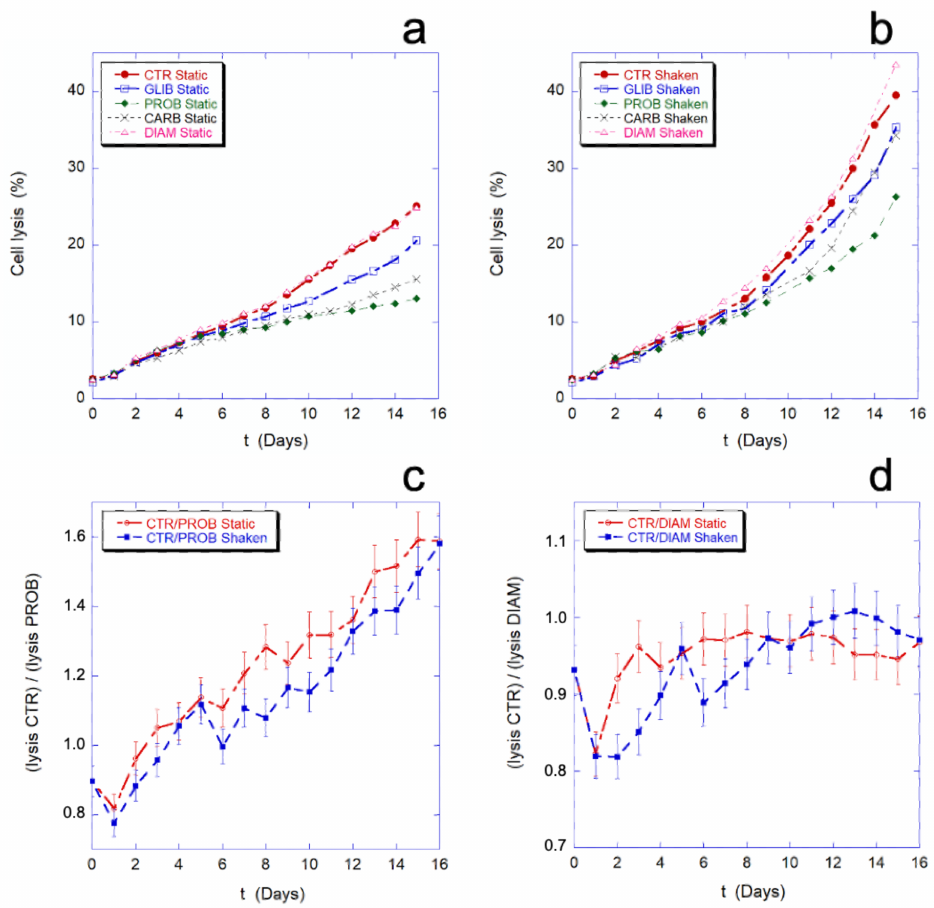
Figure 9. Panels ( a , b ) report, respectively, the percentage of cell lysis in static controls ( a ) and in mechanically stimulated cells ( b ) in the presence and absence of DIAM, CARB, GLIB, and PROB. Moreover, in panels ( c , d ) we compared the ratio of the lysis curves (shown in Figure 2a,b) for CTR/PROB ( c ) and for CTR/DIAM ( d ). The ratio has been performed both in static and in shaken conditions and is reported in the Y axis of ( c , d ). If the mechanical stimulus would provide a specific increase of cell lysis, this would result in systematic differences in the shaken vs. static trends. On contrary, the data show that mechanical stimulus always determines an increase in cell lysis ( a vs. b ) but this increasing is not mechanical stimulus-dependent as the two trends in the presence or absence of mechanical stimulus are equivalent ( c , d